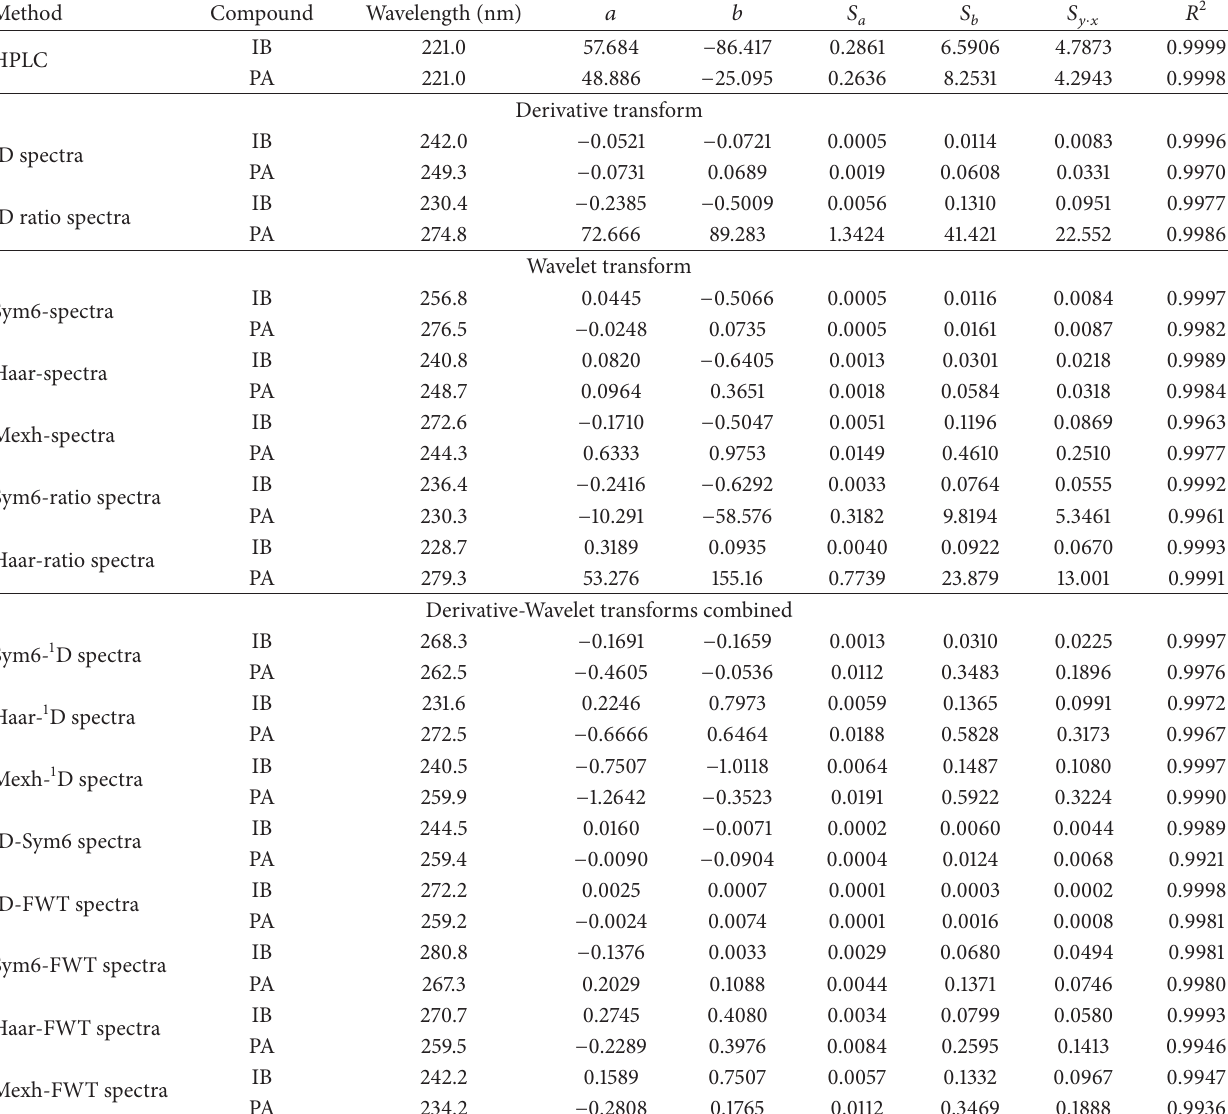
Table 1: Statistical analysis of calibration graphs of the proposed HPLC and spectrophotometric methods ( 𝑛 = 6 ), IB (12–32 mg/L) and PA (20–40